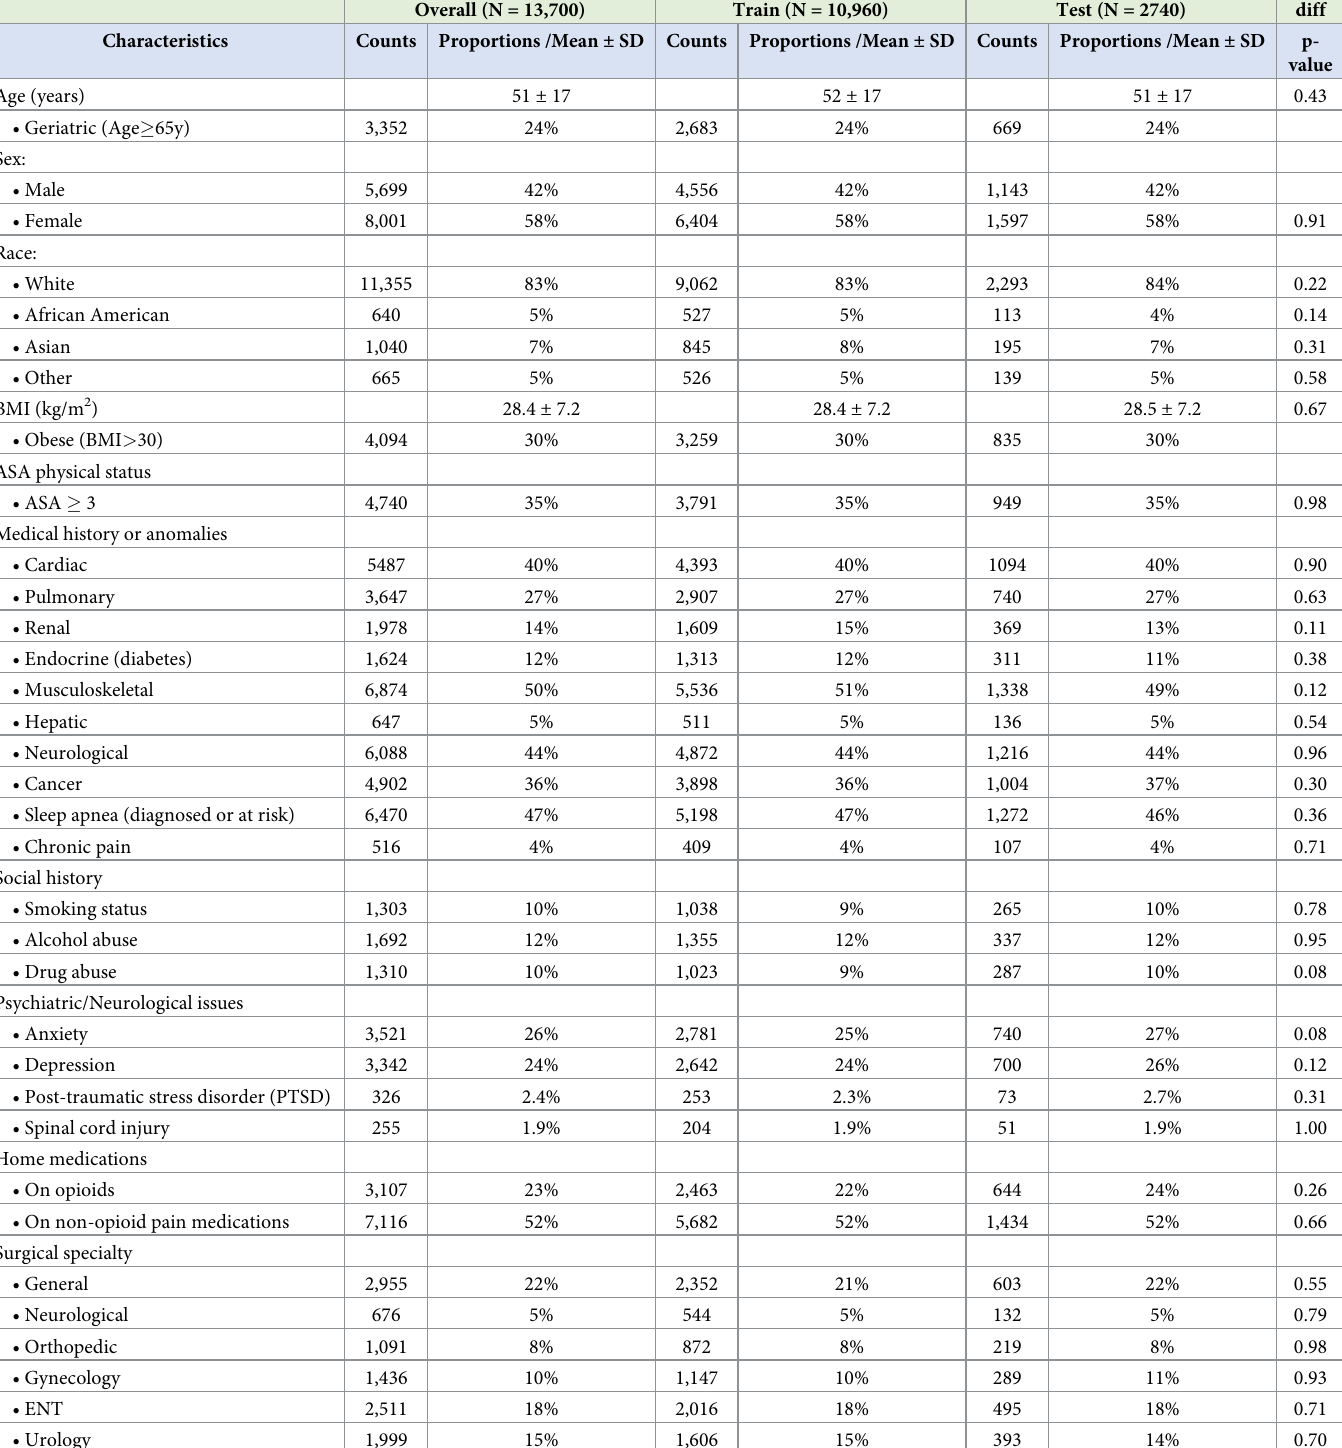
Table 3. Primary patient and procedure characteristics observed in the overall (N = 13,700), training (N = 10,960) and testing (N = 2740) datasets. Proportions are presented for categorical variables while mean ± standard deviation (SD) are shown for continuous variables. The comparison of characteristics between the training and testing datasets is also